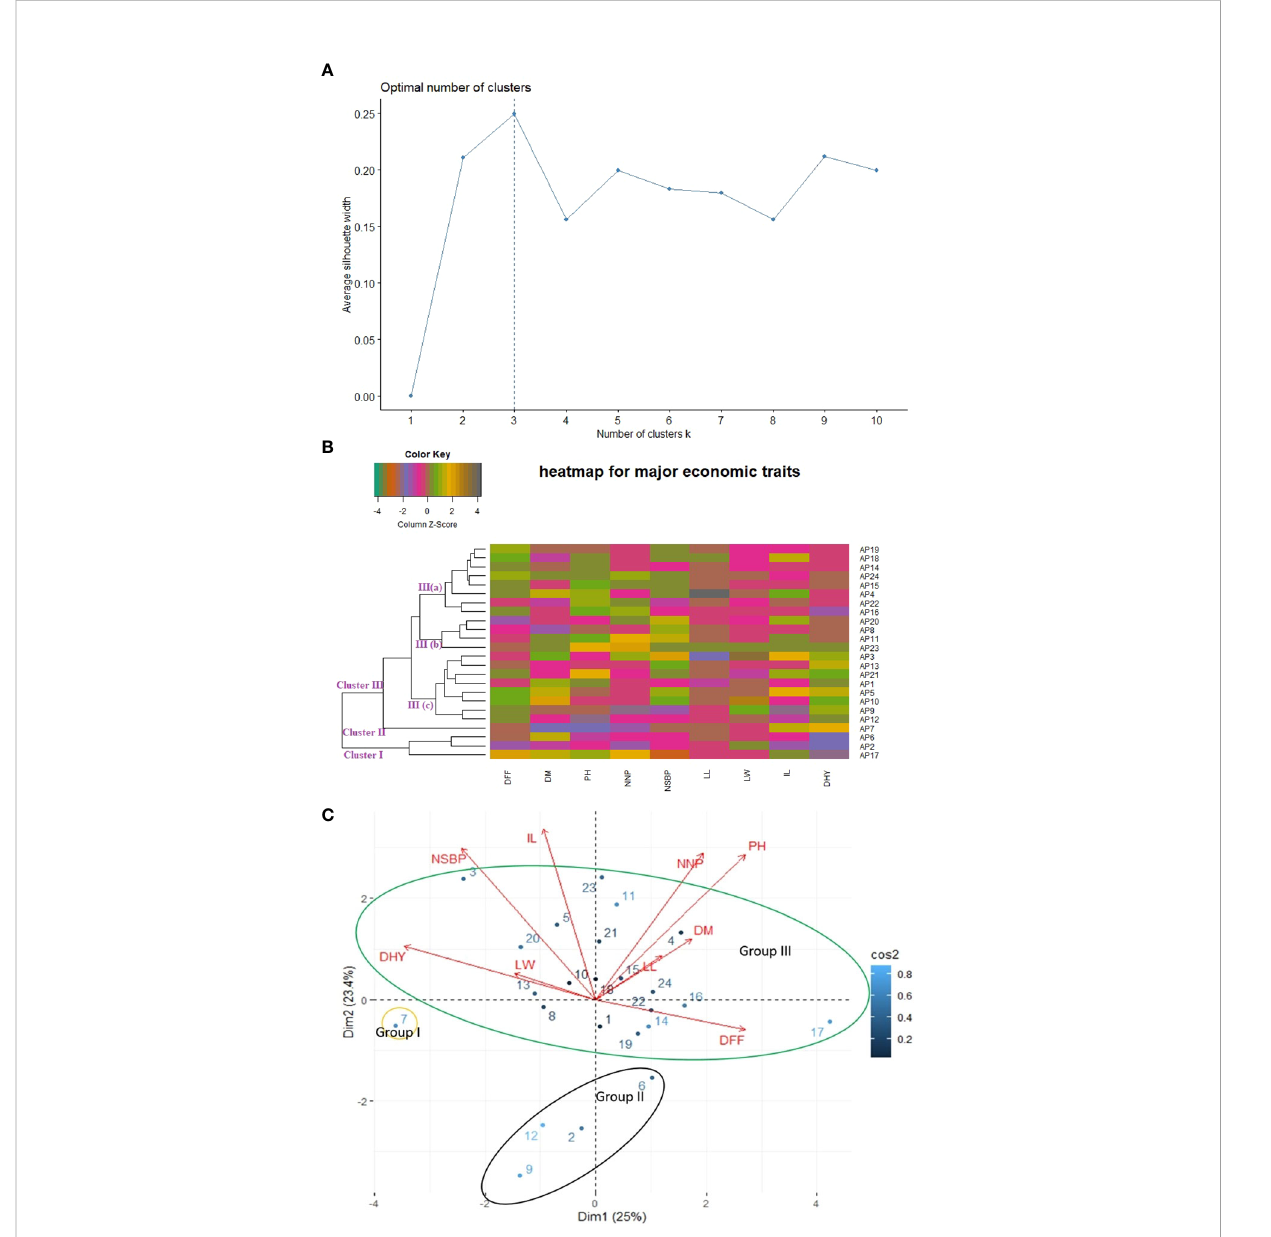
FIGURE 3 Relationship among twenty-four accessions of kalmegh based on agronomic traits using (A) k-mean (B) Euclidean distance (C) PCA